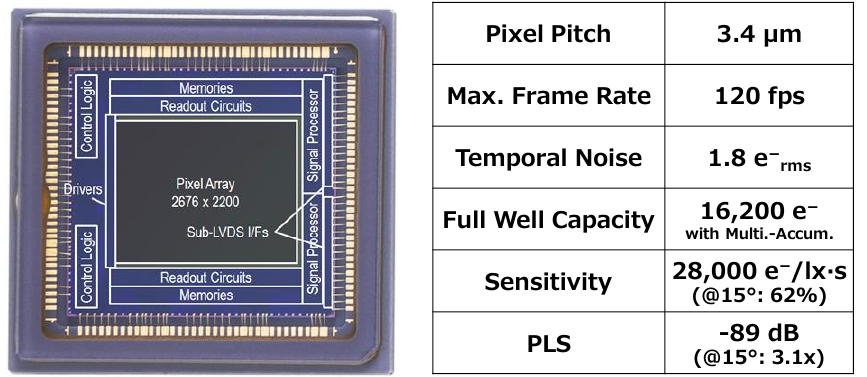
Figure 14. Chip microphotograph and pixel performance summary. Table 2. Summarized specifications and characteristics comparison.